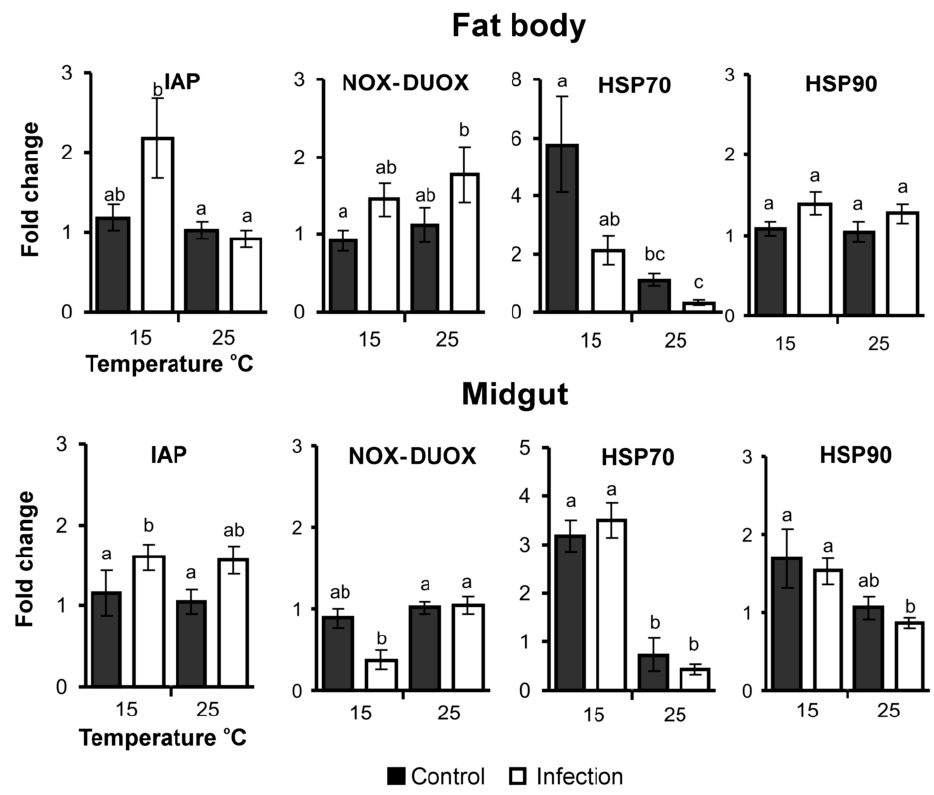
Figure 6. Relative expression of apoptosis, ROS and stress-related genes in the fat body and midgut of wax moth larvae at 96 h after injection with C. militaris (2500 conidia per larva) and subsequent incubation at 15 °C and 25 °C. Data were normalized to the expression of two reference genes, eEF1a and RBP11. The Y -axis shows the fold change relative to uninfected larvae maintained at 25 °C. Different letters indicate significant differences between treatments (Dunn’s test, p < 0.05). Table 2. Two-way effects of C. militaris infection and temperature on the expression of apoptosis, ROS and stress-related genes. Significant effects highlighted in bold. Arrows show up- or downregulation of genes in response to infection and in response to cooling to 15 degrees. Arrows are shown only for significant ( p < 0.05) and marginal ( p = 0.05–0.10) effects. Effects